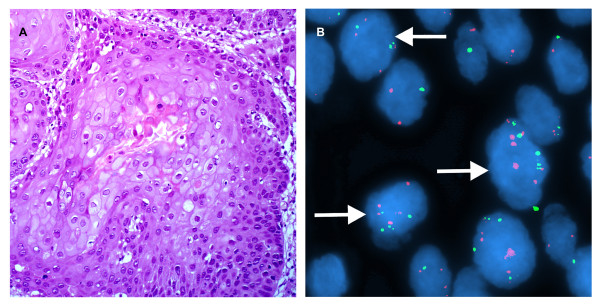
A case of invasive carcinoma . A. H&E stain. (×200). B. Interphase FISH shows the CSP3: hTERC signal pattern is 3:4, 5:5, 5:7, and etc. (×1000)